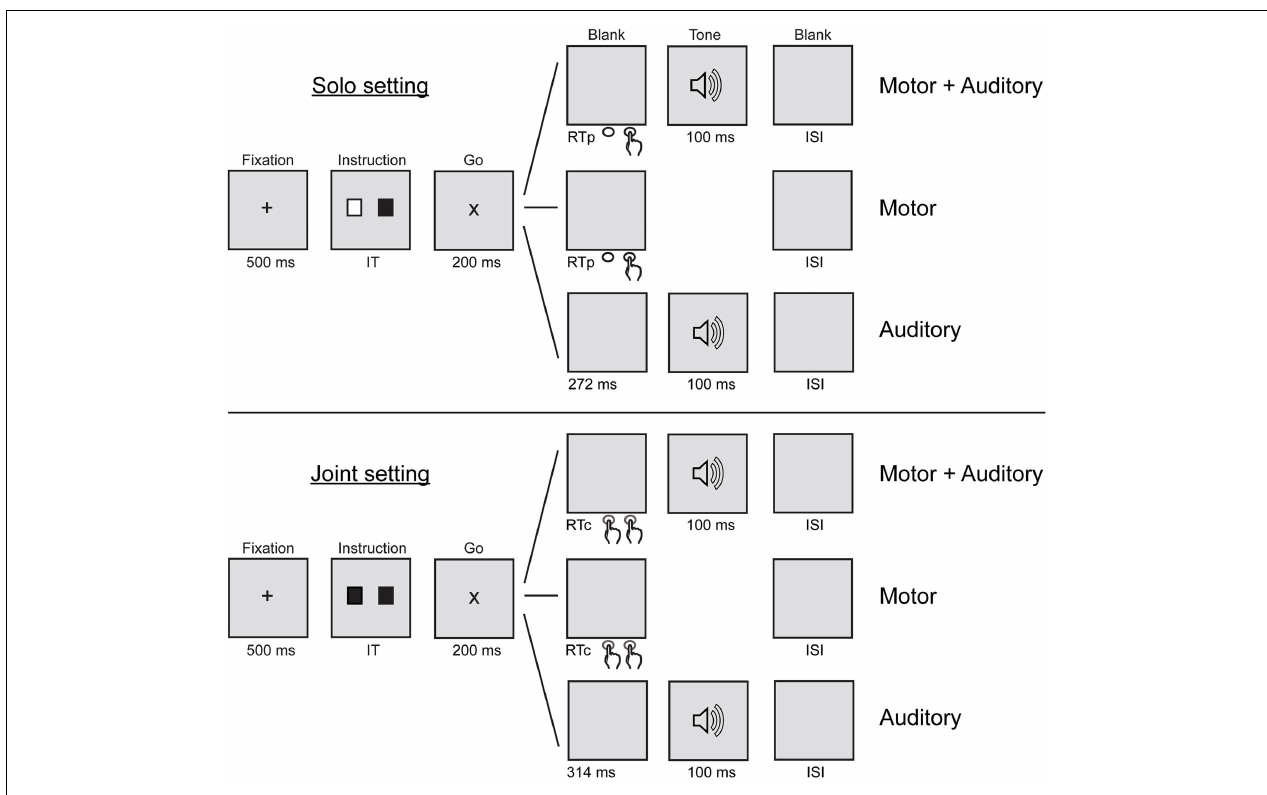
response time; RTc, coordinated response time (the longer of the participant’s or partner’s RT); ISI, inter-stimulus interval (0, 100, or